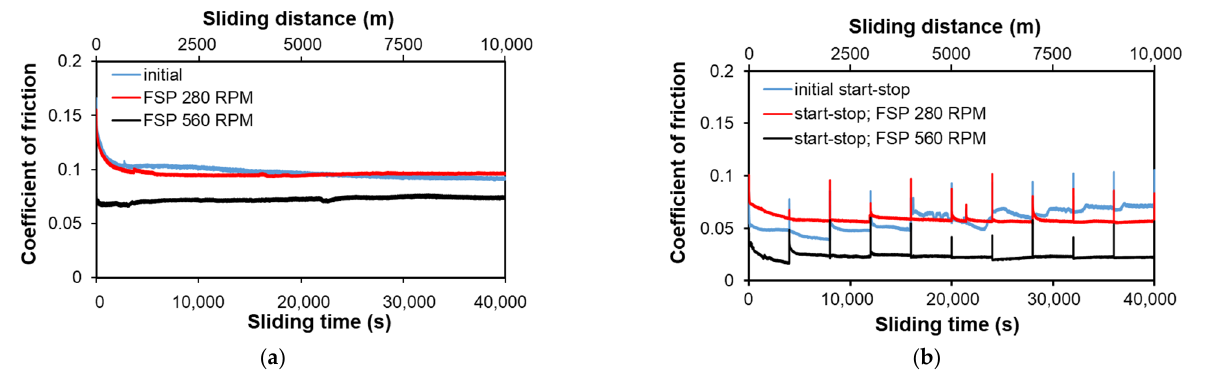
Figure 10. Coefficient of friction of B89 alloy before and after FSP as a function of time and processing conditions; ( a ) lubricated friction, load 50 N, sliding distance 10,000 m; ( b ) lubricated friction, load 50 N, start–stop 10 × 1000